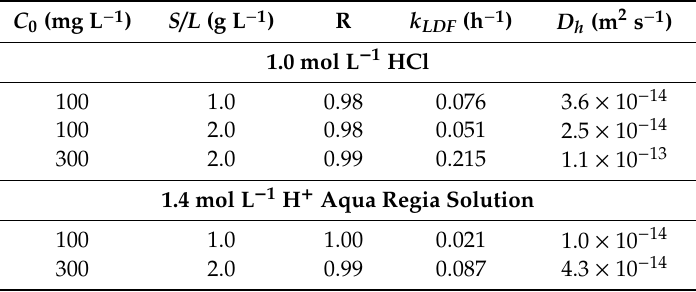
Table 4. Kinetic constant ( k LDF ) of LDF approximation and solid di ff usivity coe ffi cients ( D h ) calculated by HSDM model for the adsorption of gold from HCl and aqua regia solutions by the pine bark tannin resin.